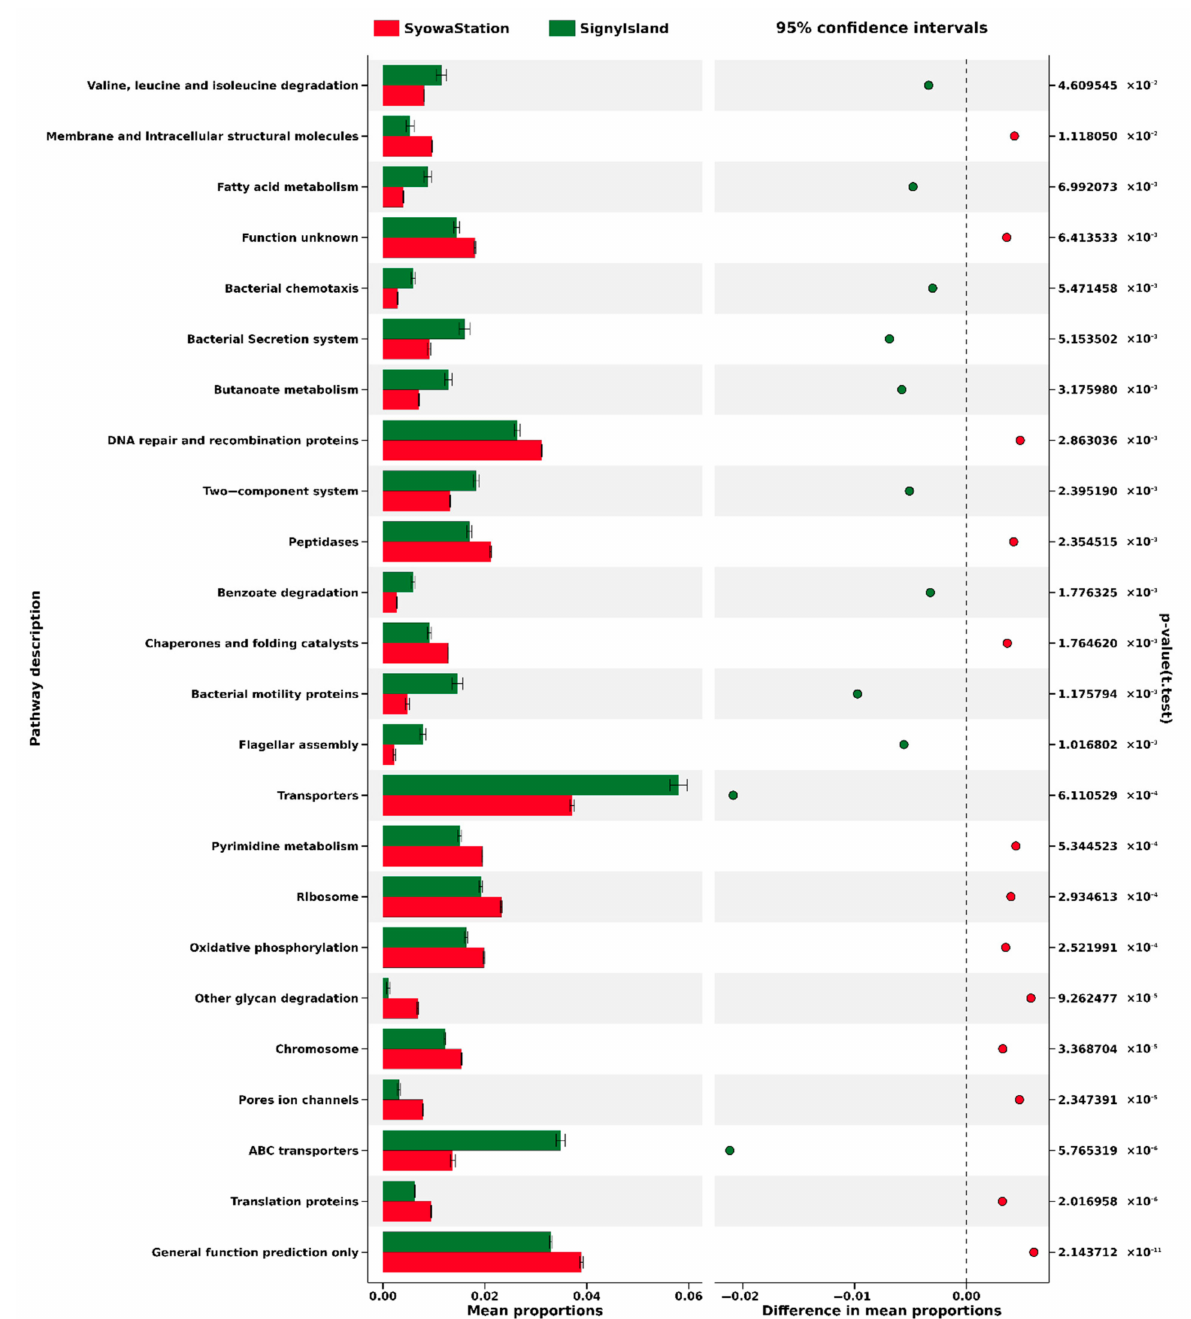
Figure 6. Excerpt of KEGG Level 3 metabolic pathways found in the biomarker OTUs from Signy Island (green) and the Syowa Station region (red). Horizontal axis indicates relative abundance (%) of each pathway to be compared between the two regions. The pathways are selected by cutoff value of mean relative abundance distance of two regions > |0.003|. Details of the KO functions are shown in Figure